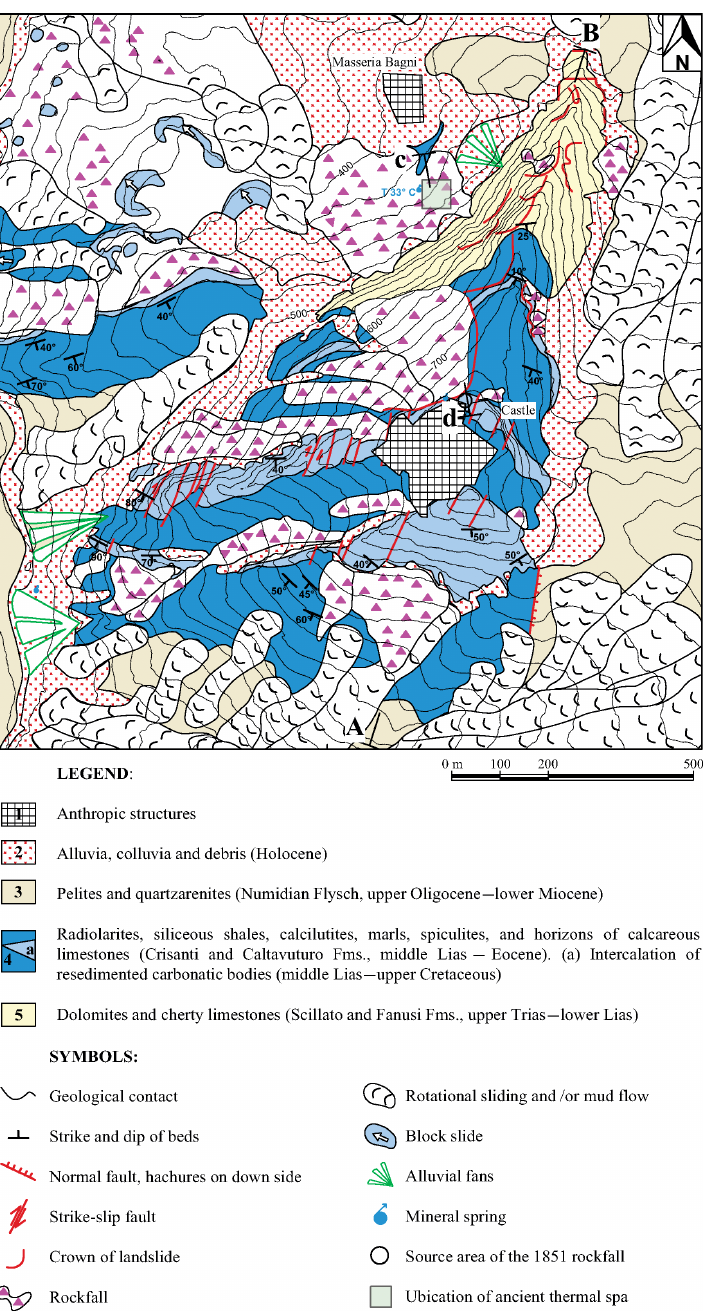
Figure 5. Simplified geological and geomorphological map of Mt Sclafani (equidistance of elevation contours: 20m), showing the sector crossed by the section A–B of Fig. 3 and the profile c–d, of Fig.